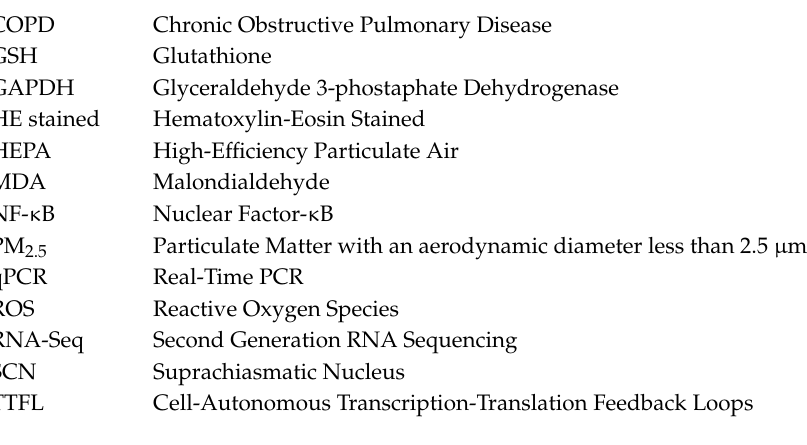
Table S1: The primer for real-time PCR, Table S2: Overlap genes of 4 groups data of RNA-Seq, Table S3: DAVID bioinformatics for functional annotation, Table S4: The circadian gene expression level, Table S5: The top 50 up-regulated genes and top 50 down-regulated genes of the first set of experiments (Mothers with normal fetus), Table S6: The top 50 up-regulated genes and top 50 down-regulated genes of the second set of experiments (Mothers with normal fetus), Table S7: The top 50 up-regulated genes and top 50 down-regulated genes of the set of experiments (Mothers with abnormal fetus), Table S8: The top 50 up-regulated genes and top 50 down-regulated genes of